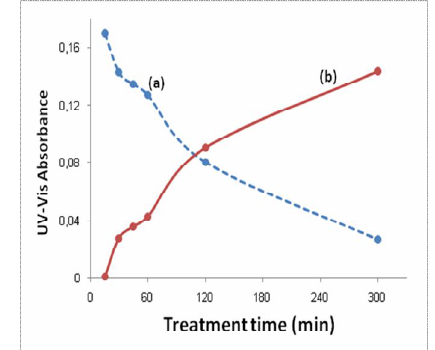
Fig. 6. Time optimization for treatment processing (a) UV- Vis absorbance of treated solution, (b) the difference of UV-Vis absorbance between non-treated solution and treated solution for different times.